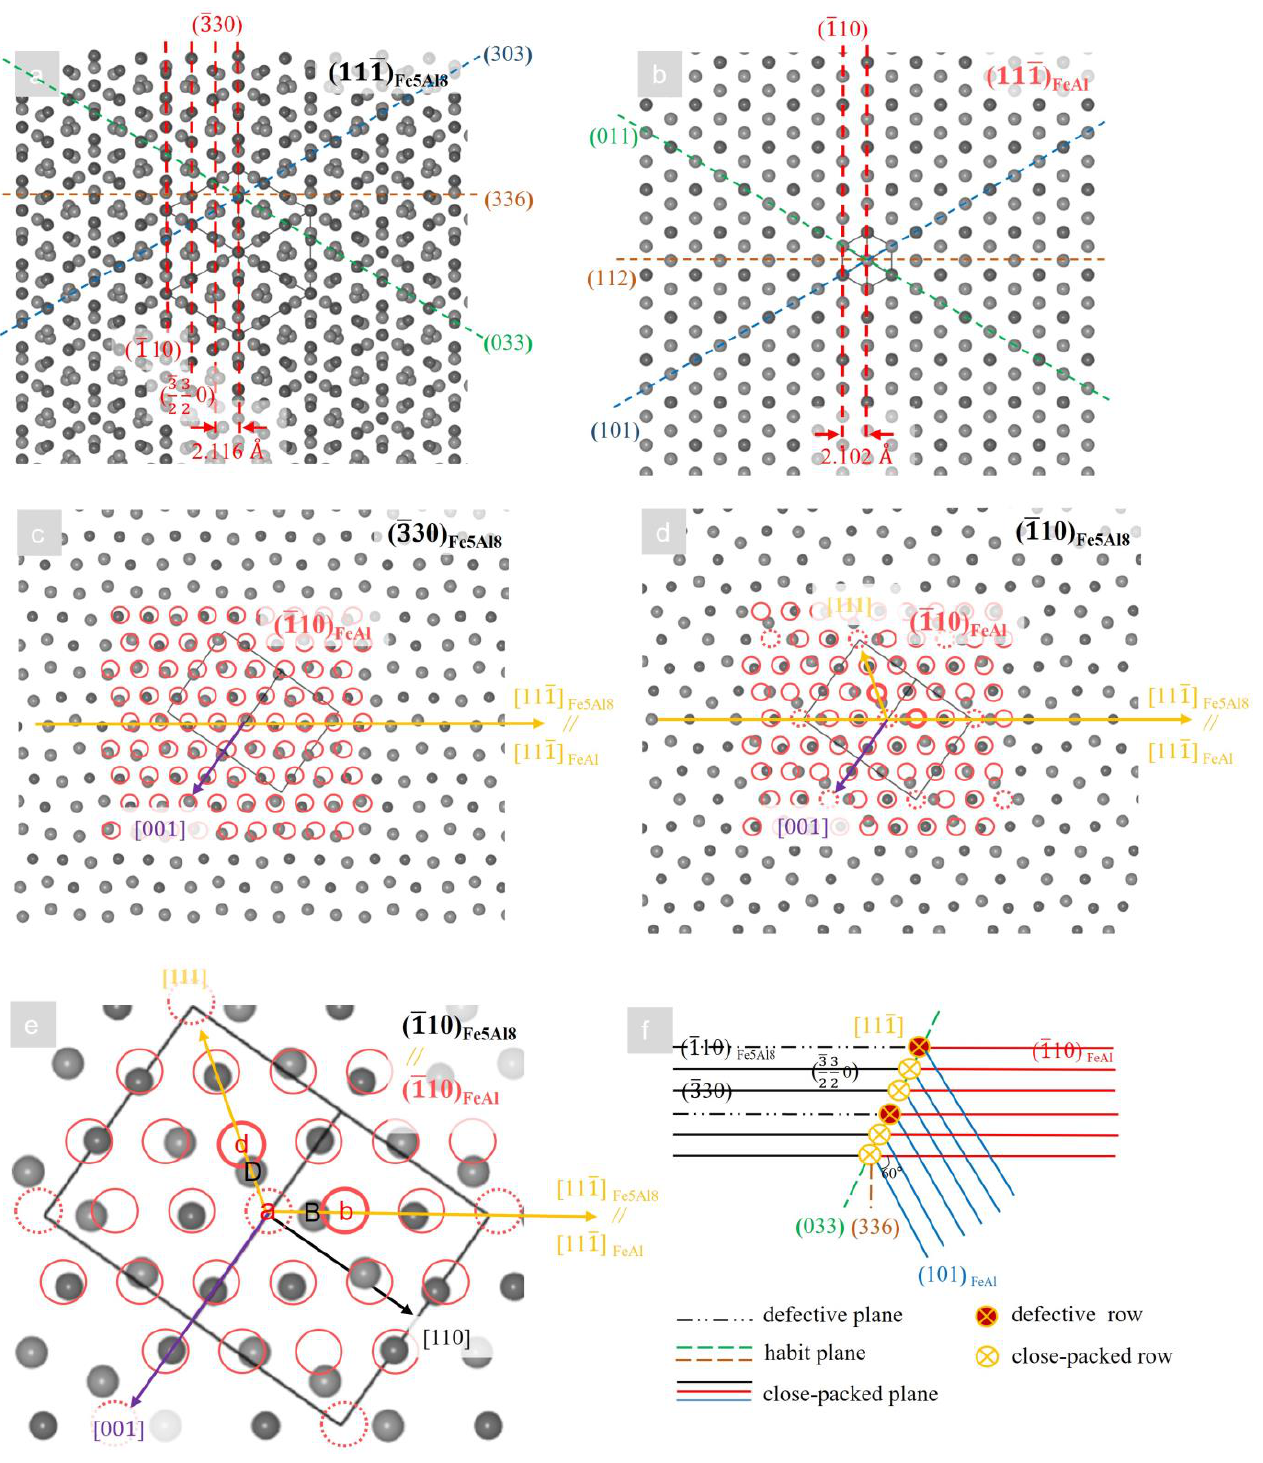
Figure 7. ( a , b ) are schematic drawings of the atomic arrangements of (11 1̅ ) Fe5Al8 and (11 1̅ ) FeAl . ( c , d ) are matching situations of Fe 5 Al 8 and FeAl atoms. ( e ) Local enlargement in ‘d’. ( f ) is a schematic view of the essential features of the E2EM model.